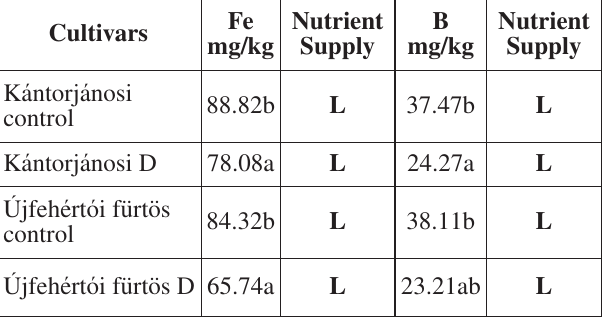
Table 6 Effect of frost on leaf Fe and B